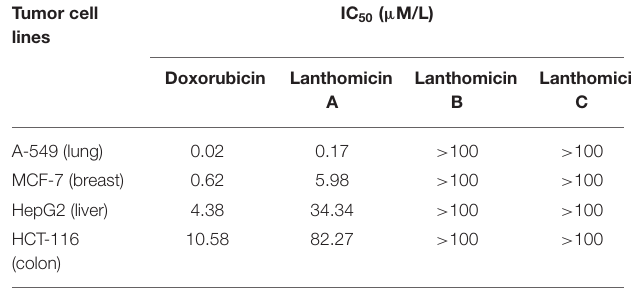
TABLE 2 | Antitumor activity of